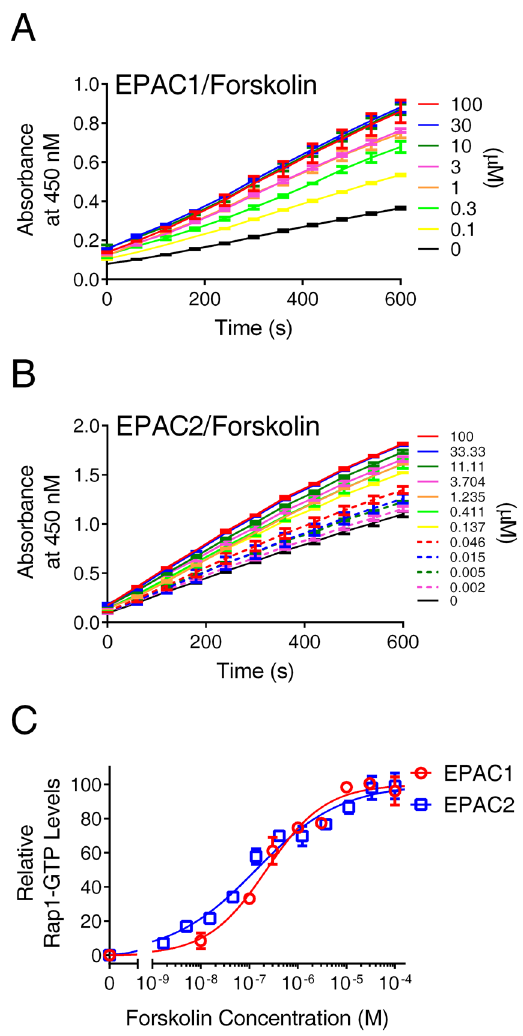
Figure 3. Dose-dependent cellular activation of EPAC1 and EPAC2 by forskolin. ( A ) Time course of EPAC1- mediated Rap1 activation in response to forskolin stimulation. ( B ) Time course of EPAC2-mediated Rap1 activation in response to forskolin stimulation. ( C ) Relative Rap1-GTP levels as a function of forskolin concentration in HEK293 cells overexpressing EPAC1 or EPAC2, respectively. Data are presented as Means ± SD, n =